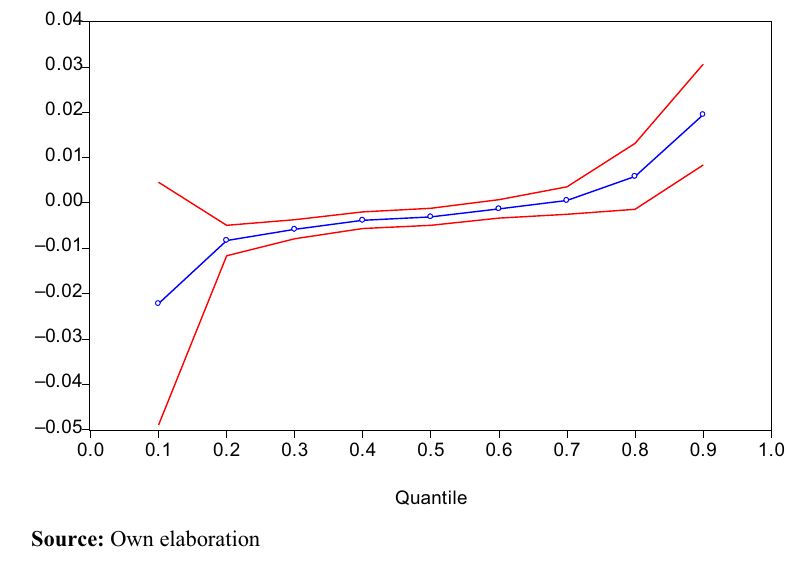
Figure 13. The quantile process estimates for OPEC news on the Brent oil futures over the period from April